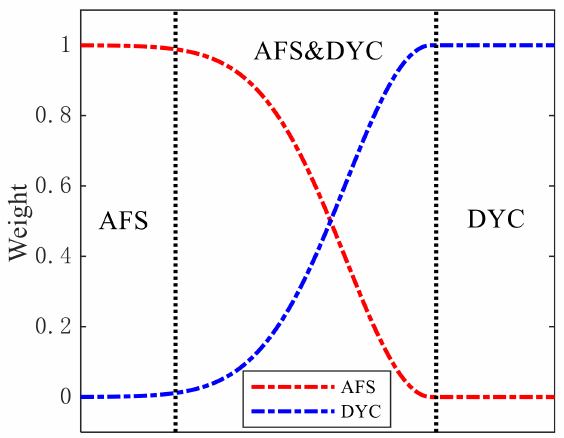
Figure 11. Weight of AFS and DYC.